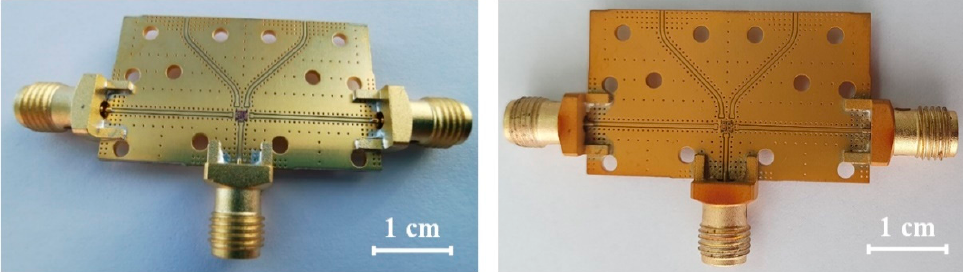
Figure 5. The board with Sub-Miniature version A (SMA) plugs before ( left ) and after ( right ) deposition of aluminum oxide and alumina nitride ceramics.